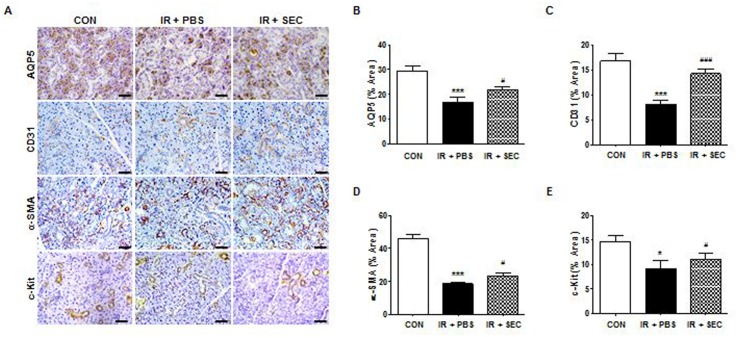
Cytoprotective effect of hAdMSC secretome treatment.(A) Representative images of salivary epithelial (AQP5), endothelial (CD31), myoepithelial (α-SMA), and progenitor cells (c-Kit) in the SG in the three experimental groups. Scale bars represent 50 μm. (B-E) Each staining area was measured in pixels using a software program. Data are presented as the mean area (%) ± SEM. One-way ANOVA, Tukey’s pot hoc test. *, compared to CON; #, compared to IR + PBS. *P < 0.05, ***P <0.001, #P < 0.05, and ###P < 0.001. CON, normal control group; IR + PBS, PBS-treated group; IR + SEC, secretome-treated group. Three random sections from each mouse were evaluated by a blinded researcher. The total number of slides examined from each experimental group ranged from 18 to 21.